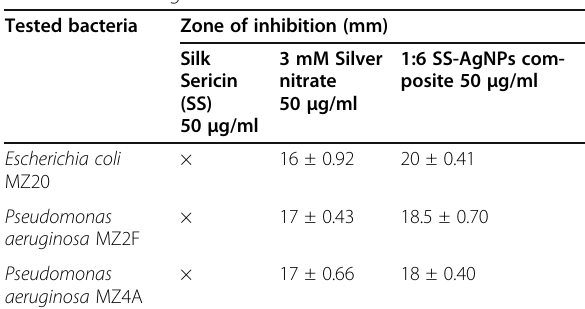
Table 4 Antibacterial activity of silk sericin, AgNO 3 , and 1:6 SS- AgNPs against multidrug-resistant Escerichia coli